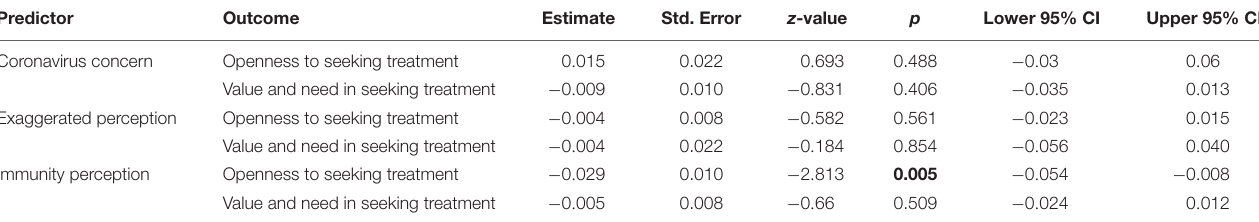
TABLE 8 | Total indirect effects of CAS-10 subscales on ATSPPH-SF subscales. Predictor Outcome Estimate Std. Error Coronavirus concern